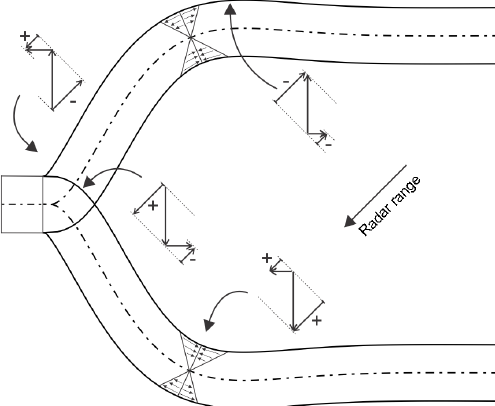
Figure 3. Schematic of grounding zone ice shelf flexure, bend- ing stresses, and associated surface displacement components in radar range at low and high tide. Surface extension (convex sur- face shape) causes a horizontal displacement component towards the sensor (“ − ” for radar range shortening) and vice versa (“ + ” for radar range lengthening). The neutral layer located in the middle of the beam experiences only vertical